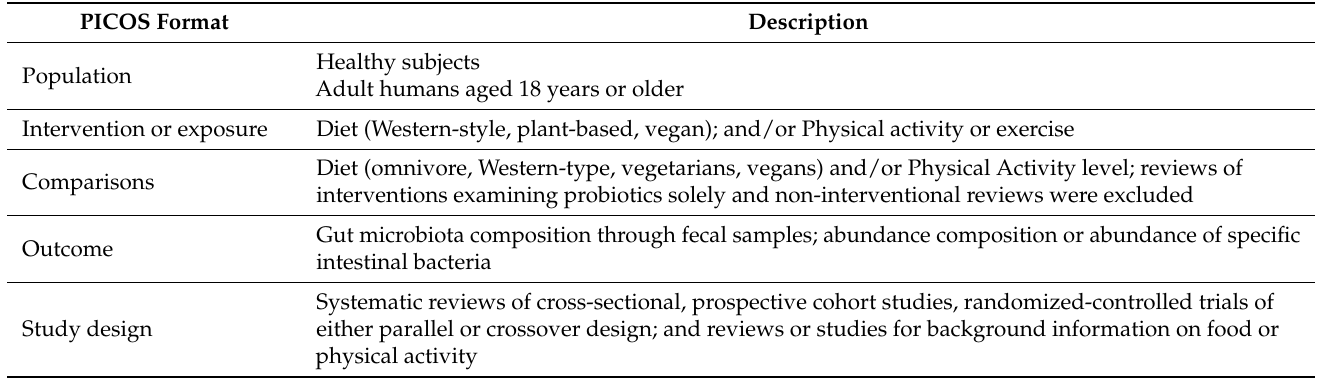
Table 1. PICOS criteria for inclusion.